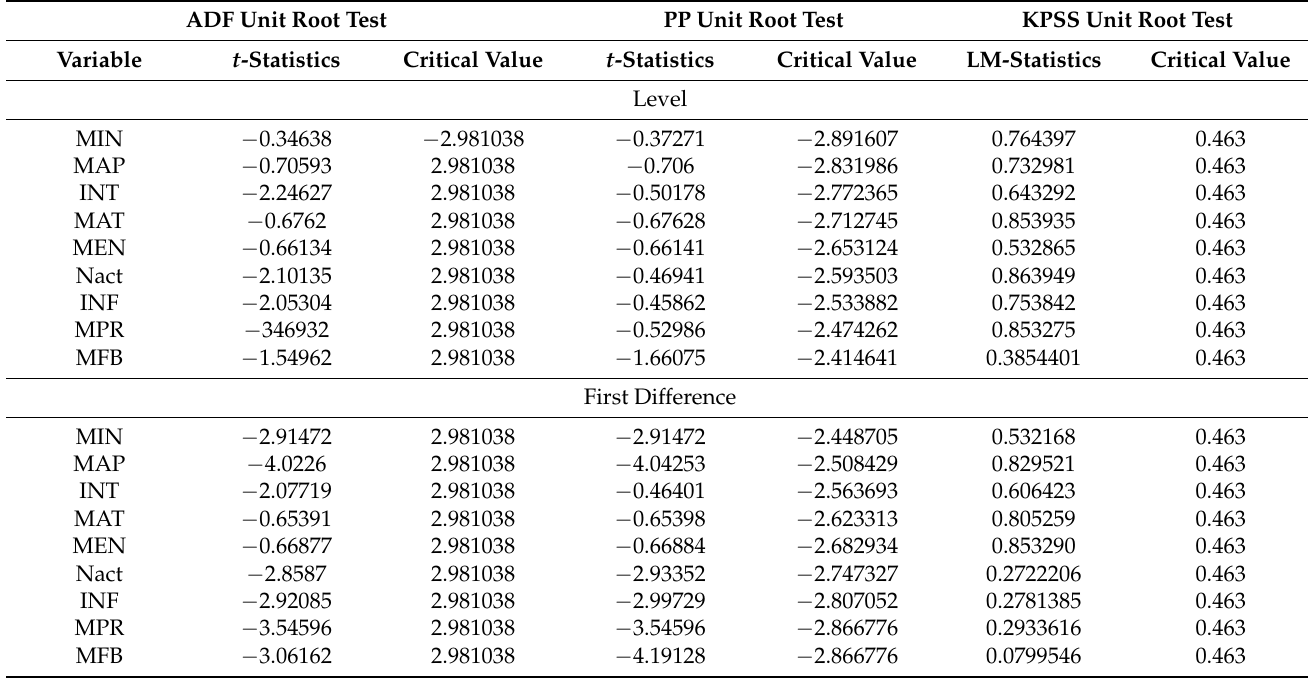
Table 3. Results of non-stationarity and staionarity tests for whole